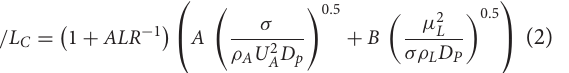
the fuel density; and D p is the pre-filmer diameter. From this equation, we can ascertain that increasing viscosity will result in bigger mean droplet size produced by the atomizing